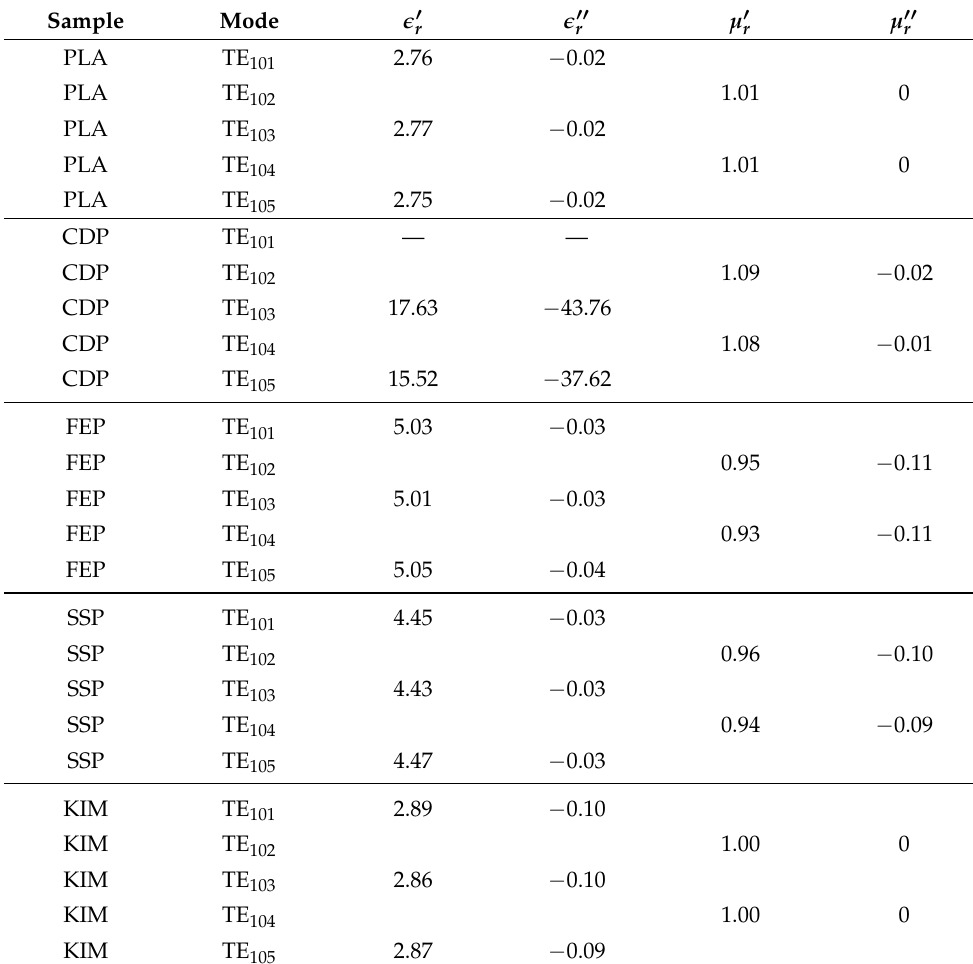
Table 4. Extracted material parameters for the material